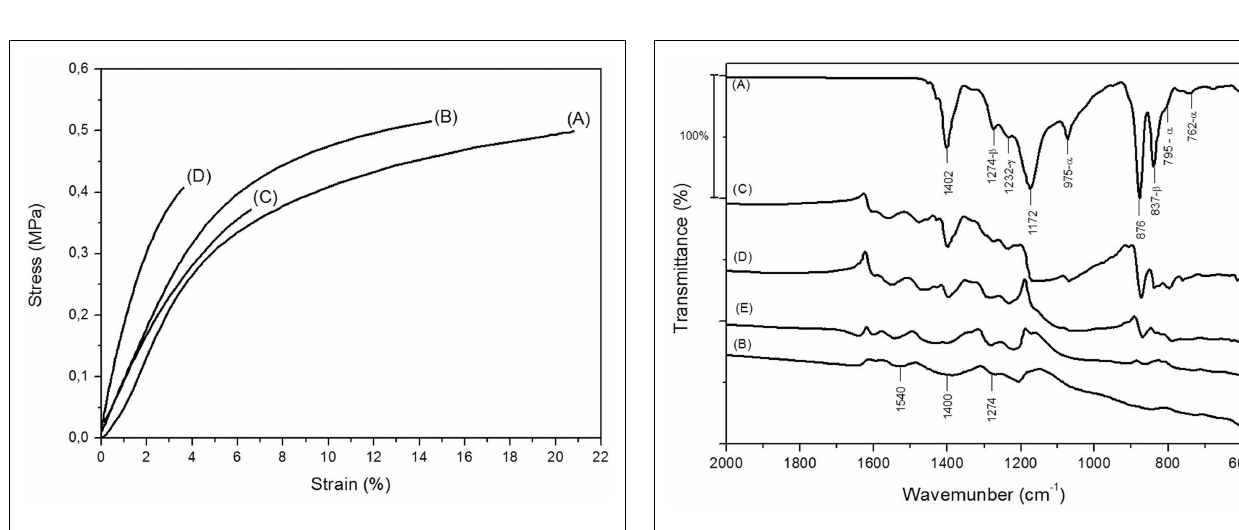
FIGURE 6 | FTIR spectra of (A) electrospun PVDF mats, (B) neat PANI, (C) PVDF/PANI [0.1], (D) PVDF/PANI [0.3], and (E) PVDF/PANI [0.5]